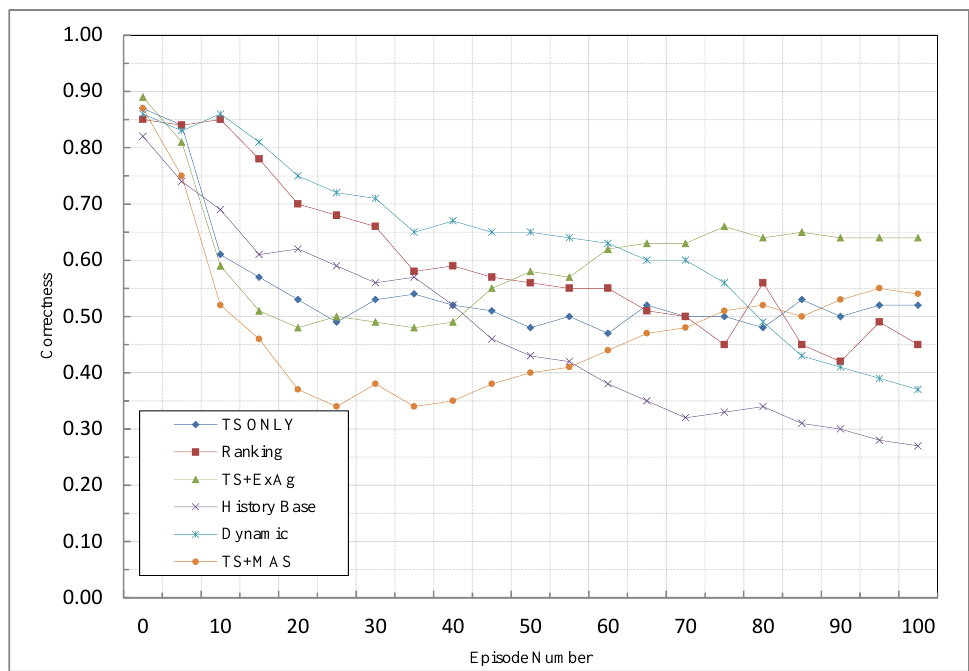
Figure 8. Comparison of MCA methods based on correctness criterion.